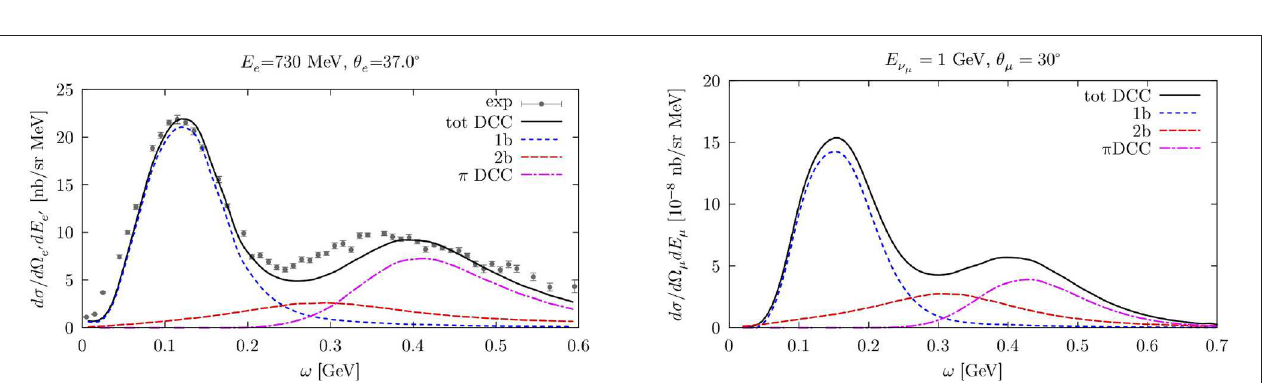
curve correspond to the CBF and SCGF SFs, the blue